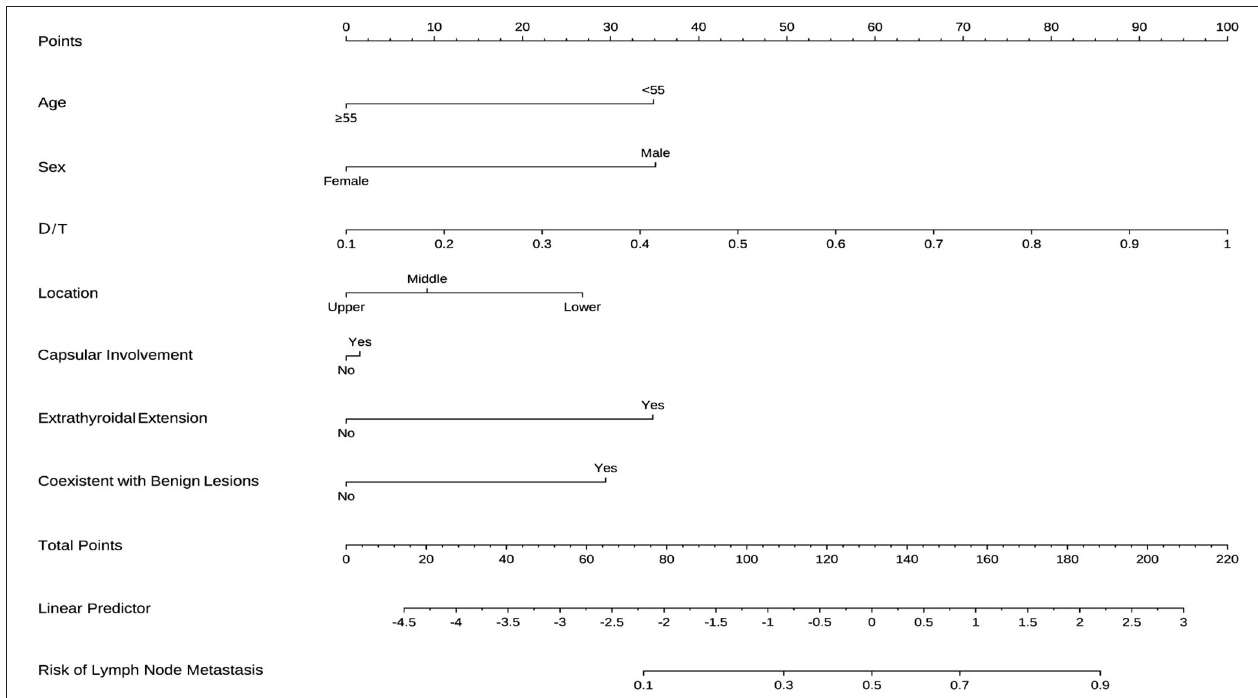
FIGURE 3 | Nomogram for predicting CLNM in cN0 unilateral PTMC